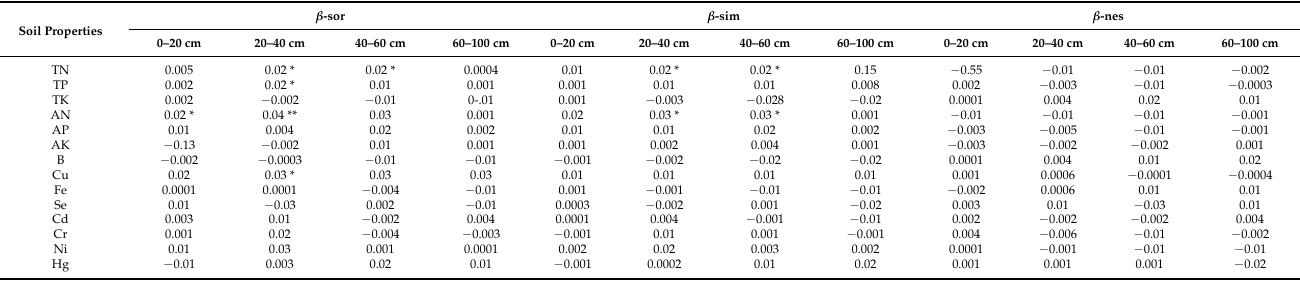
Table 3. The coefficients of Pearson correlation and Mantel test between β -diversity components of shrubs and soil factors of different depths.